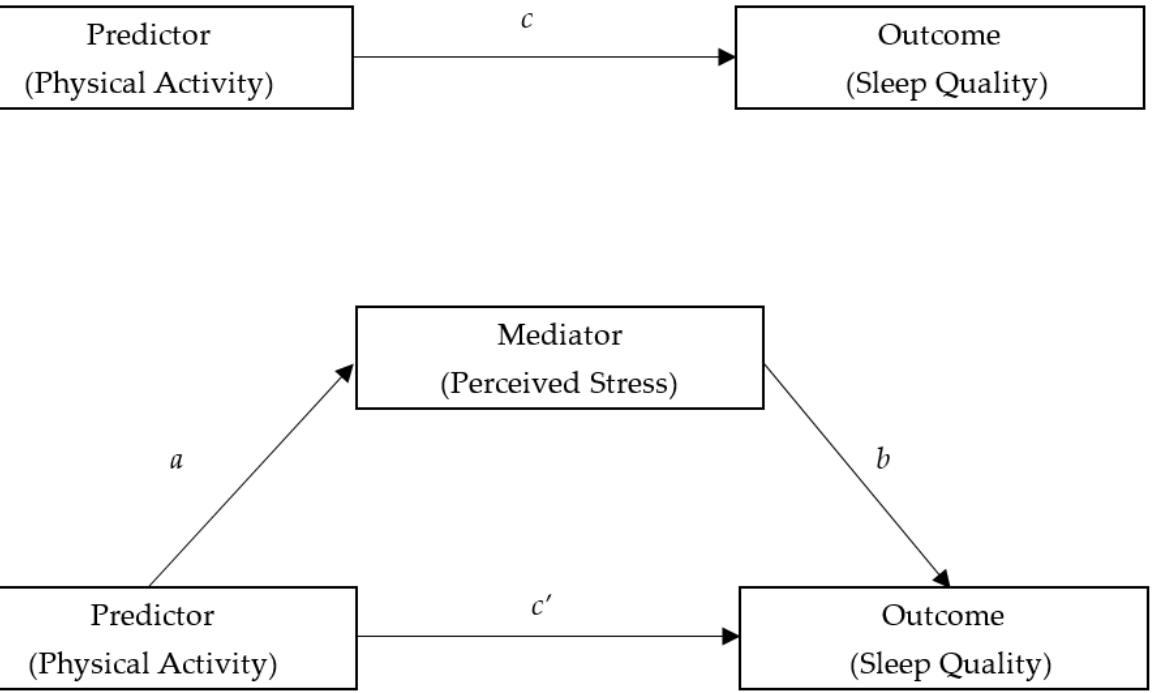
Figure 1. Conceptual model: how perceived stress mediates the association between physical activity and sleep quality. Note: a , b , c , and c' refer to the path of models (more details in the method documentation).